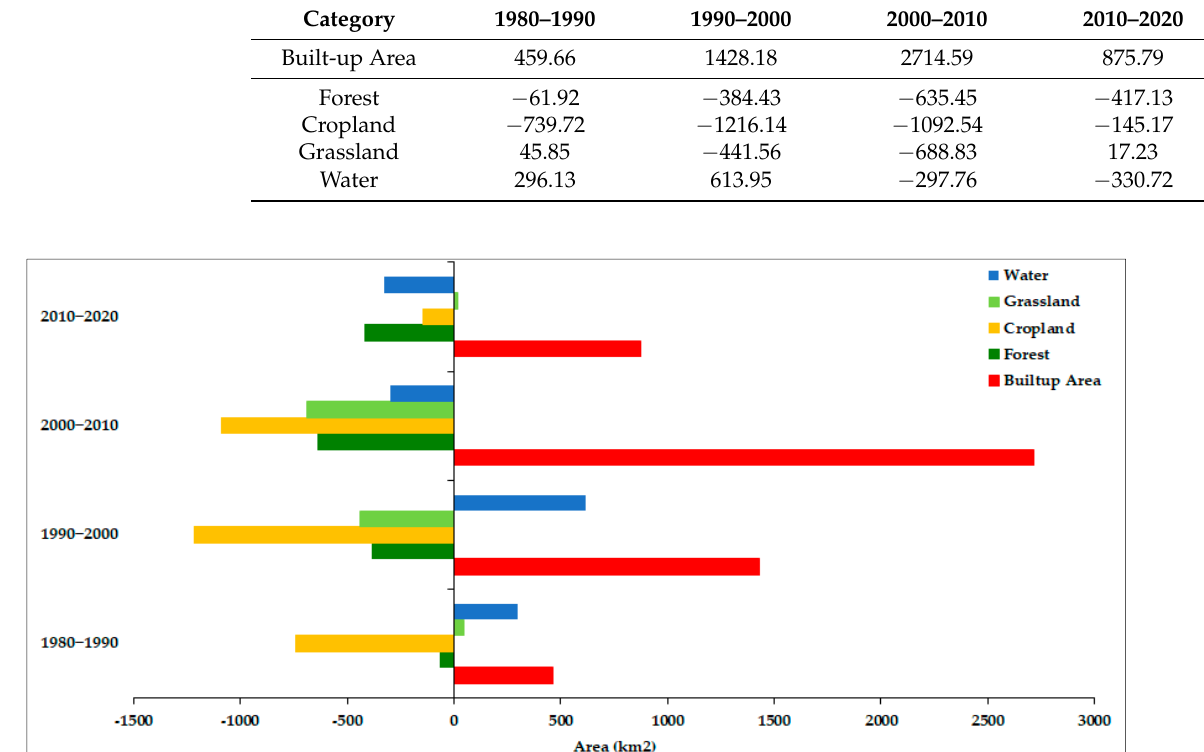
Table 13. Gains and losses of each category (km 2 ).